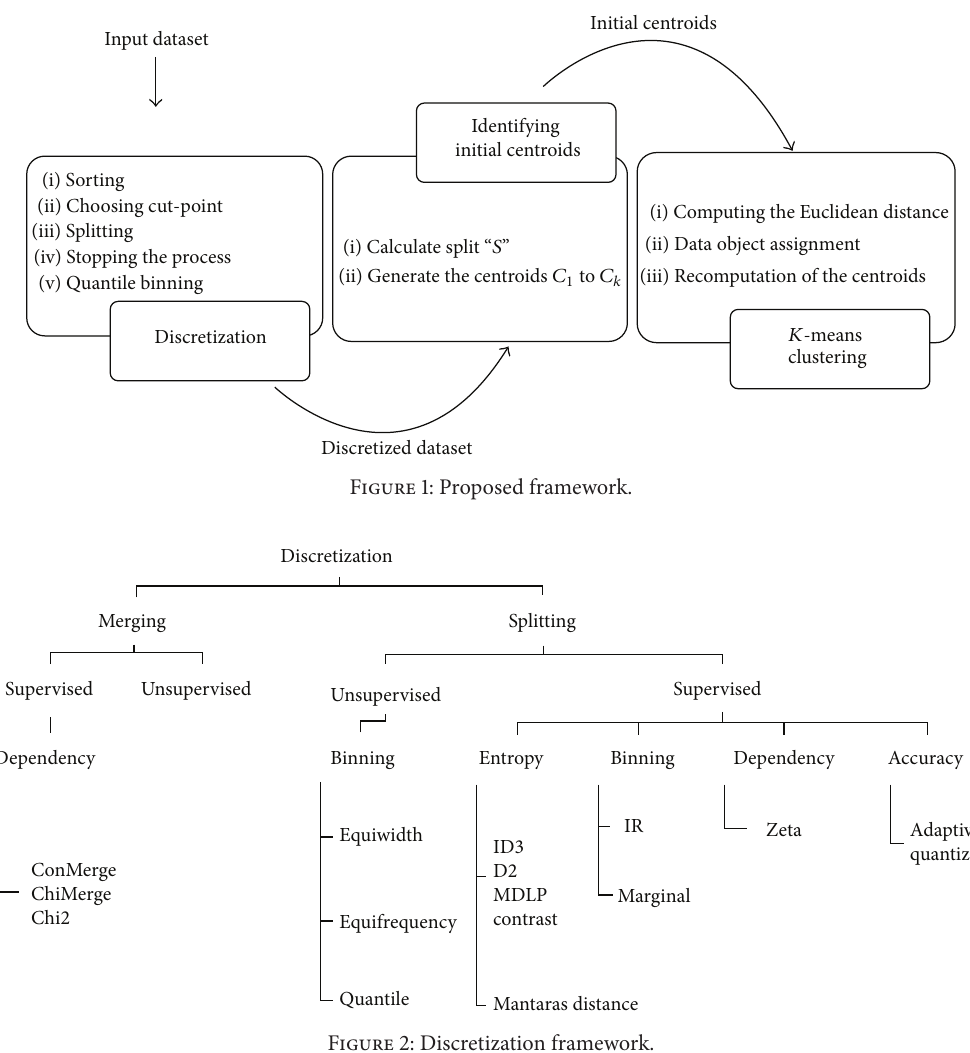
Figure 2: Discretization